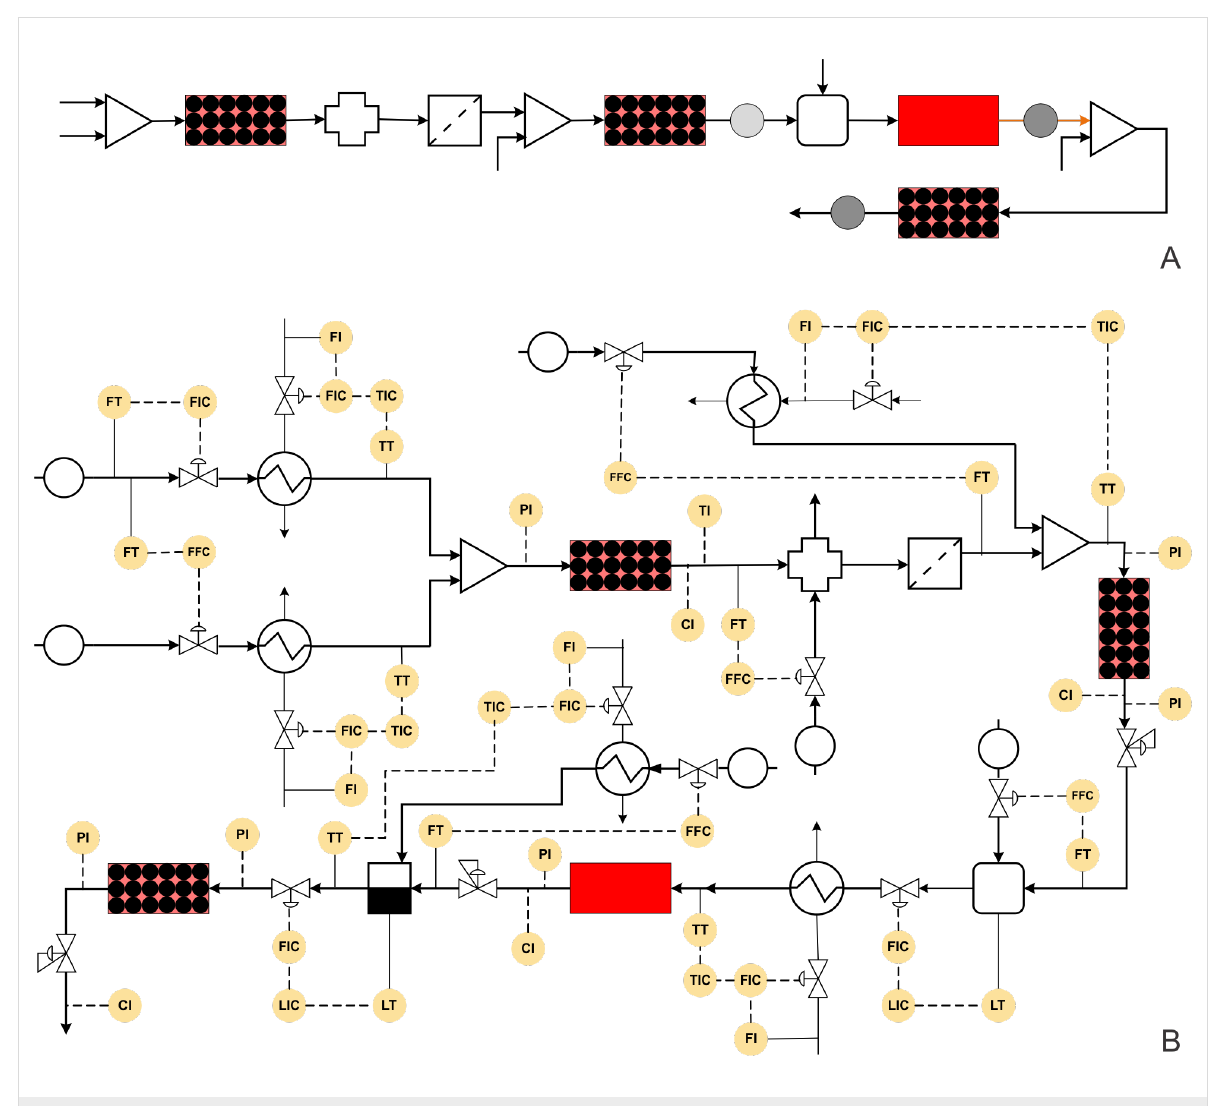
Figure 3: (A) Block diagram representation of the process shown in Scheme 1, (B) piping and instrumentation diagram of Scheme